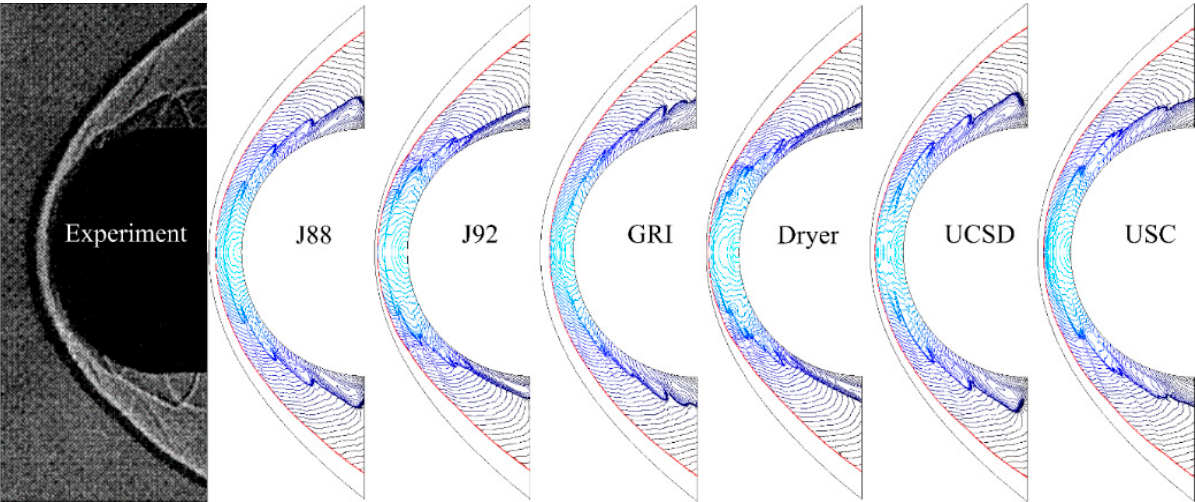
Figure 11. Mach contour of the shock-induced combustion at Mach number 4.48 with various reaction mechanisms (300 × 450 grid system) compared with experimental shadowgraph image [7] (min 0, max 4.48, increment 0.04, colored with Mach number).